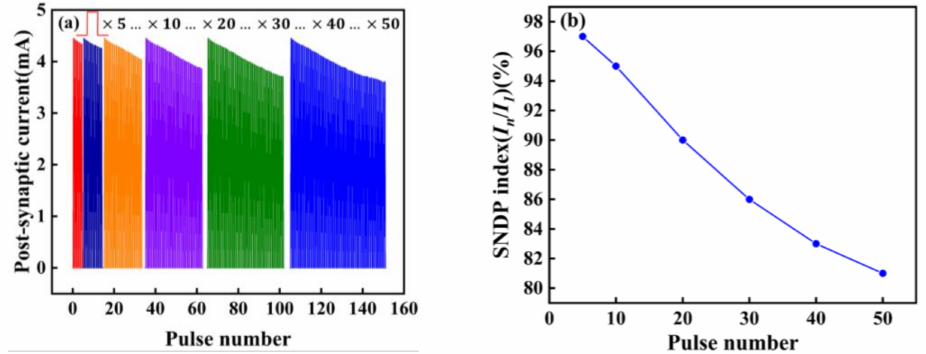
Figure 7. ( a ) SNDP; ( b ) SNDP index ( I n / I 1 ) of the Au/CsPbI 3 /ITO synaptic artificial synapse. The number of pulses is 5,10, 20, 30, 40, and 50. ( I n / I 1 ) is the ratio of the amplitude of the PSC under the last pulse stimulation to the amplitude of PSC under the first pulse stimulation. The voltage of pulses is 0.5 V.